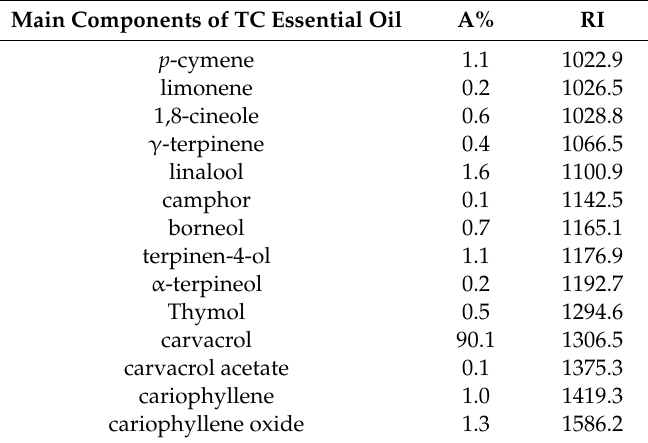
Table 2. Main components of TC essential oil as analyzed by GC / GC-MS techniques. Results are expressed as relative percentages obtained by internal normalization of FID chromatogram. RI: experimental retention indexes on HP5